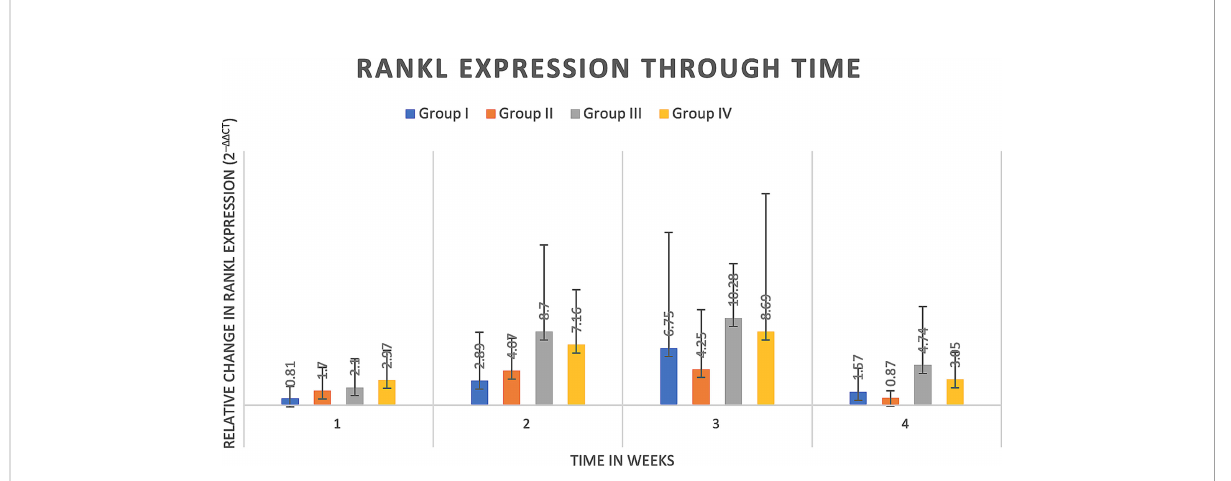
FIGURE 4 RANKL expression through time expressed as relative fold gene expression. RANKL expression trends higher at weeks two and three and declines at week four. No signi fi cant differences were detected between groups through